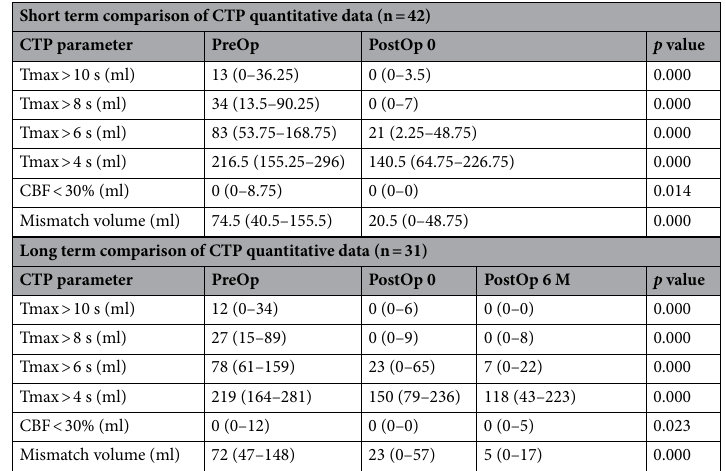
Table 2. Short- and long-term comparison of CTP data (median (interquartile)). CBF, cerebral blood flow; CTP, perfusion computed tomography; preOp, preoperative; postOp 0, immediate postoperative; postOp 6 M, postoperative 6 months; Tmax,